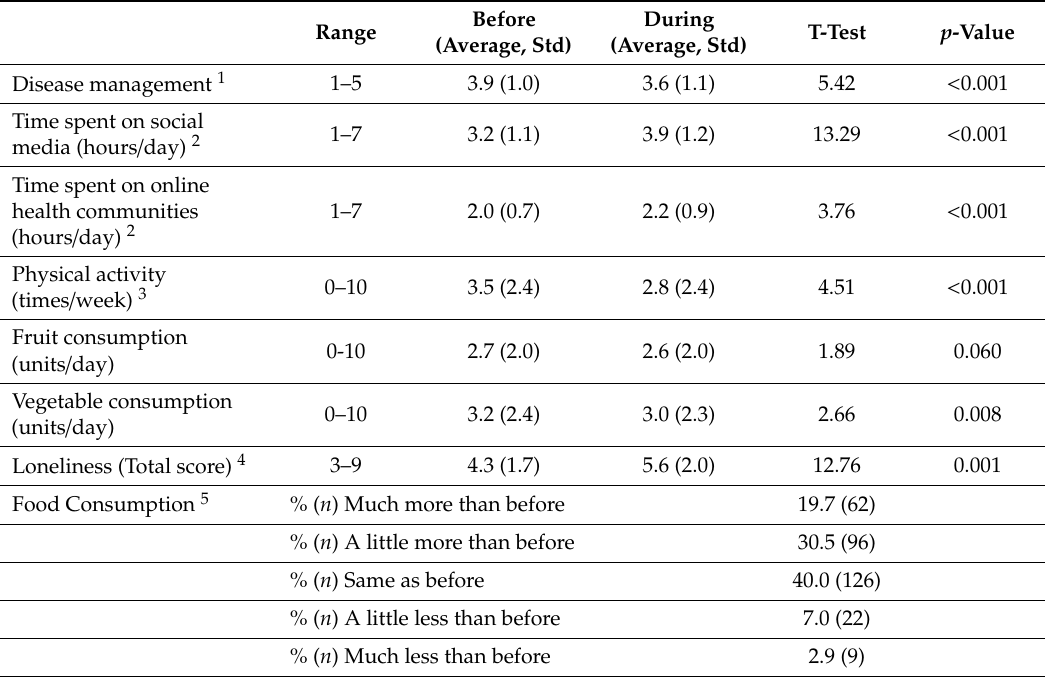
Table 3. Changes in health behaviors and loneliness one month into the COVID-19 outbreak among 315 adults with chronic medical conditions. Before Range (Average,